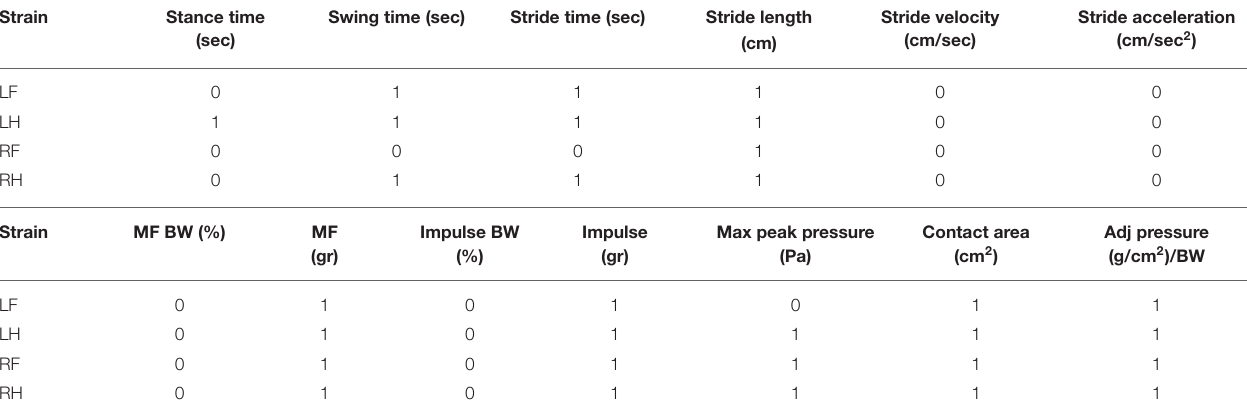
TABLE 4 | Mean comparison between Sprague Dawley and Lewis groups based on limbs. Strain